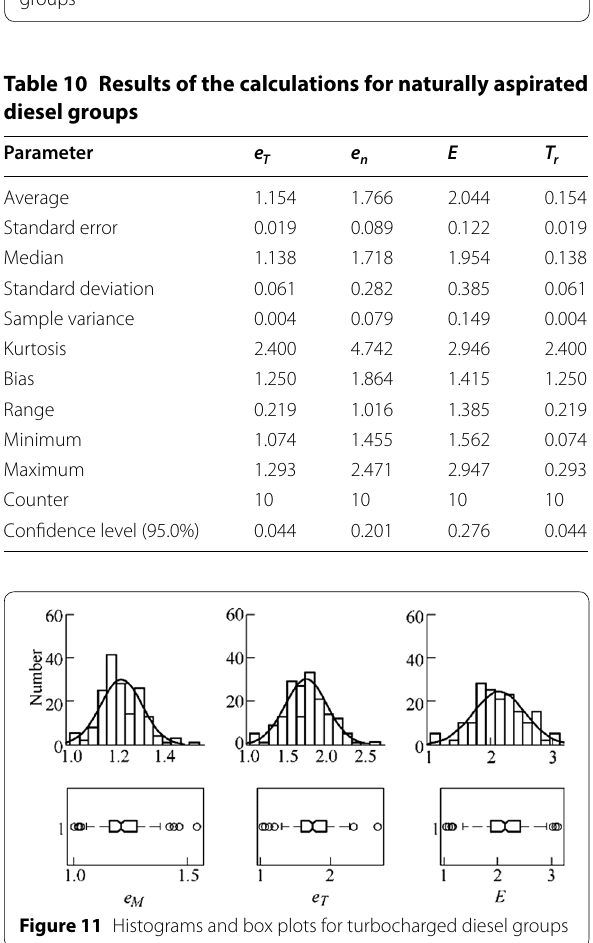
Figure 10 Histograms and box plots for naturally aspirated diesel groups